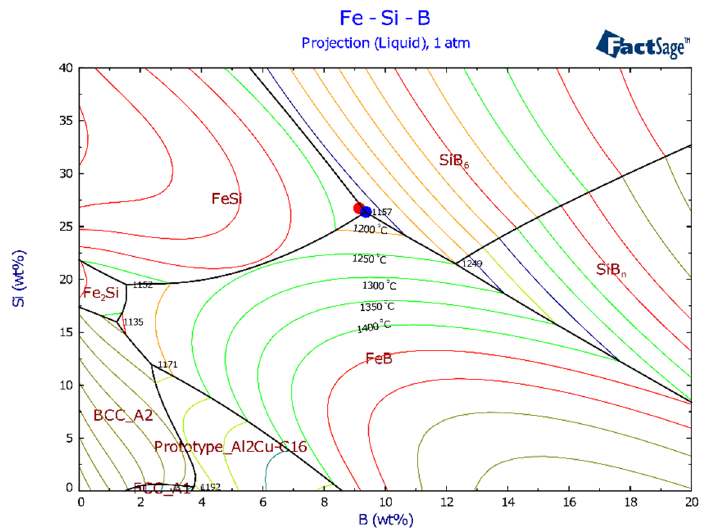
Figure 6. Projection of Fe-Si-B system, where the red point represents the composition of the master Fe-26Si-9B alloy, and the blue point represents the eutectic point. Calculated by FactSage 7.2 based on the FTlite database.